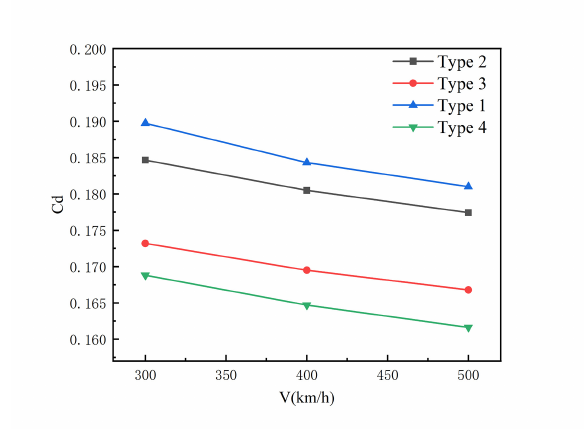
Fig. 8. Aerodynamic drag coefficients of trains with different forms of